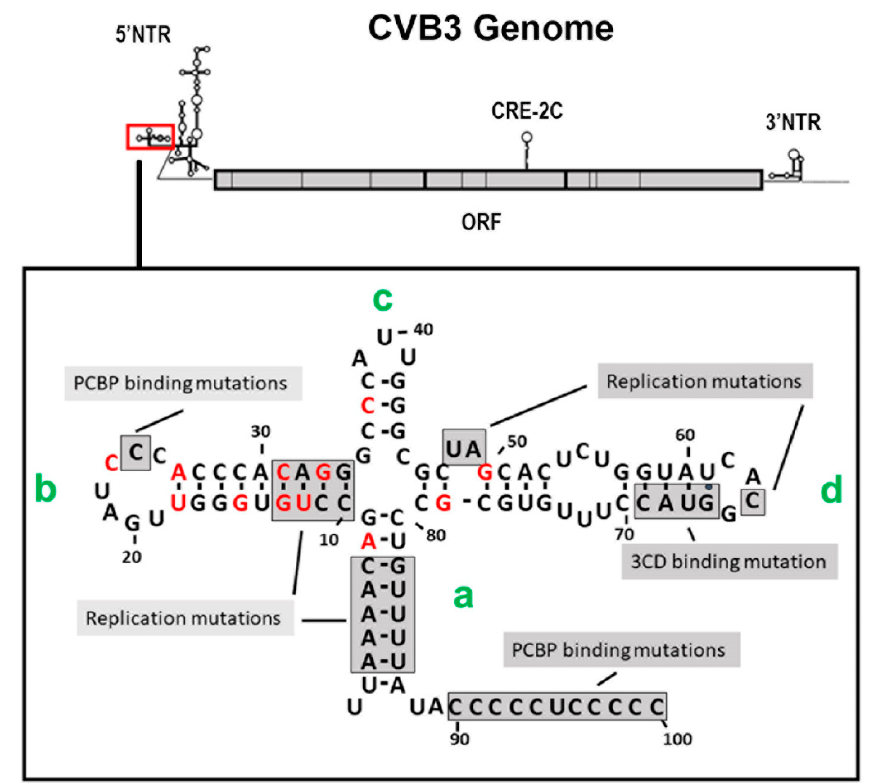
Figure 2. Cloverleaf of CVB3. Green letters (a, b, c, and d) refer to stem and stem-loops. Red letters indicate the first nucleotide of CVB-TDs generated in cell culture or in vivo. Shaded regions indicate sites of mutations in enterovirus genomes.